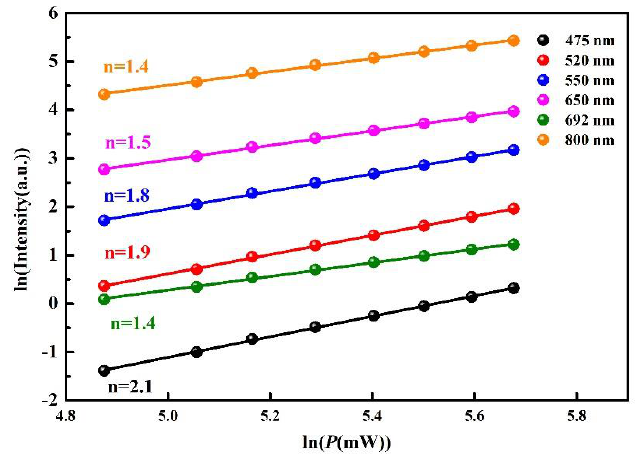
Figure 4. Ln-ln plot of emission intensity against the excitation power for NaYF 4 :Er/Tm/Yb phosphors.